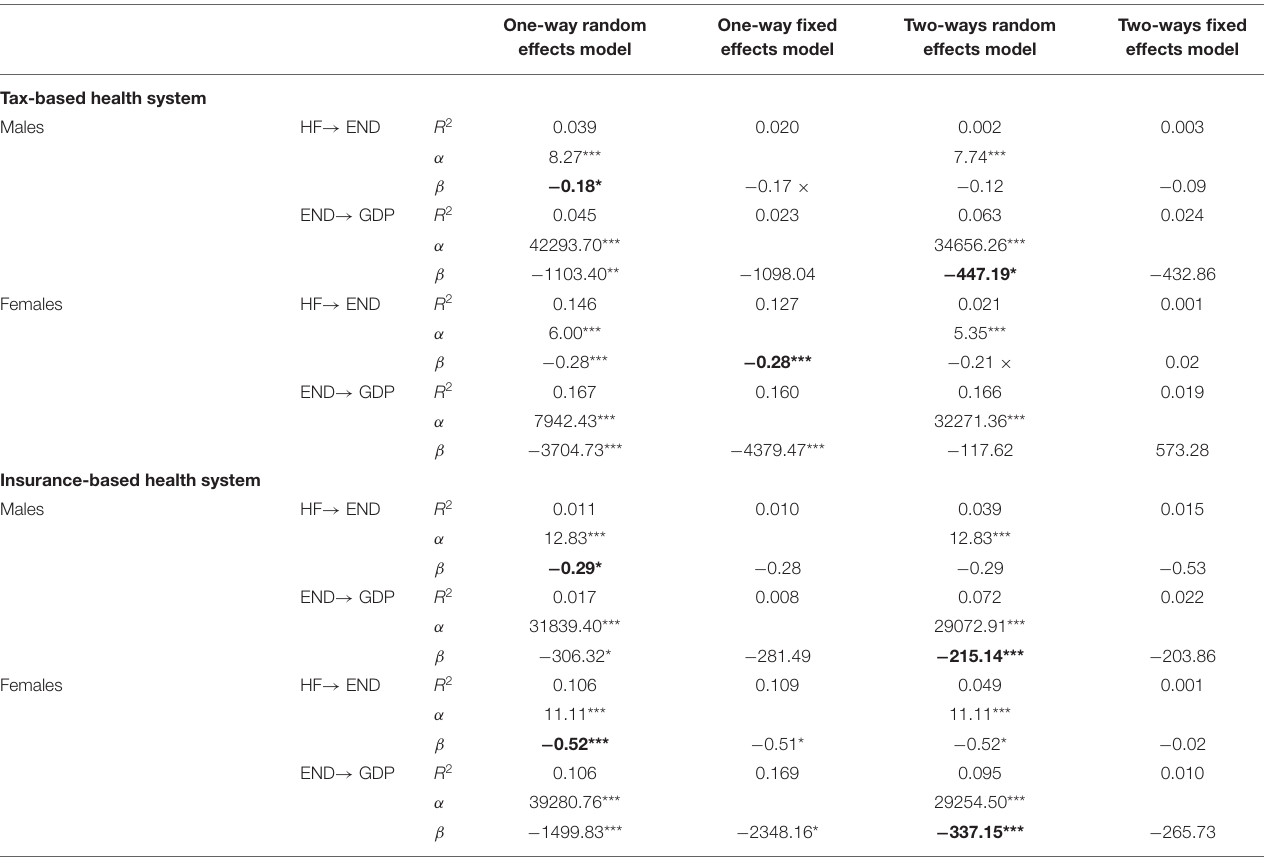
TABLE 5 | Regression analysis—associations between health care financing, treatable mortality from endocrine, nutritional and metabolic diseases and economic